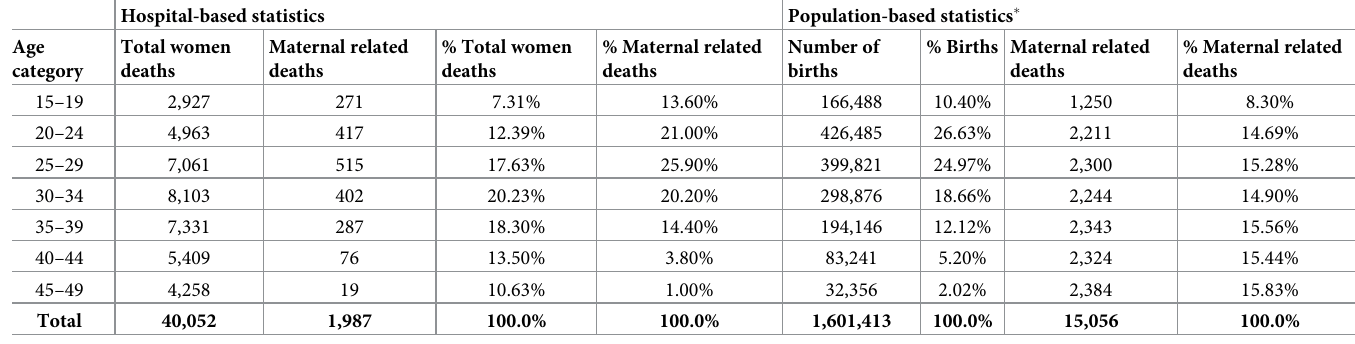
Table 1. The distribution of number and percentage of hospital- and population-based maternal deaths and births by age category. Hospital-based statistics